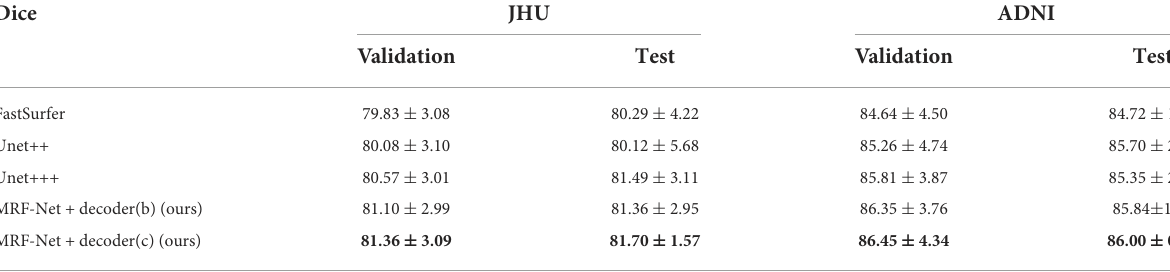
TABLE 1 The average Dice scores for 4 comparative networks on the axial segmentation results.